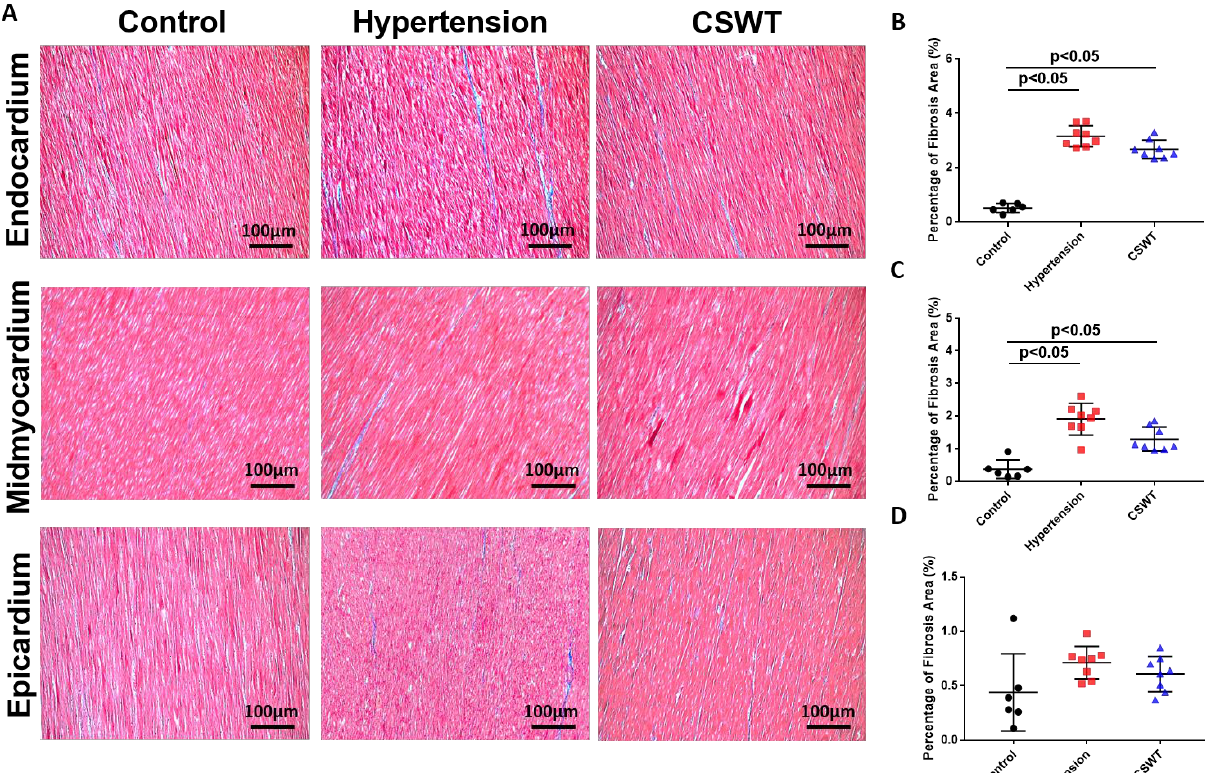
Figure 4. CSWT effect on fibrosis level in hypertensive cardiomyopathy. Masson’s trichrome staining of heart sections in the three groups at the 20th week. ( A ). The degree of fibrosis in endocardium, midmyocardium and epicardium were assessed by Masson’s trichrome staining. ( B ). In endocardium, percentage of fibrosis area in hypertension and CSWT groups increased significantly compared with control group. CSWT did not reduce the degree of fibrosis in CSWT group compared with hypertension group. ( C ). In midmyocardium, induction of hypertension significantly increased the degree of fibrosis in hypertension and CSWT groups compared with control group. CSWT did not reduce the degree of fibrosis in CSWT group compared with hypertension group. ( D ). No significant difference of the degree of fibrosis was observed in epicardium among the three groups. Independent Student t -test was used.